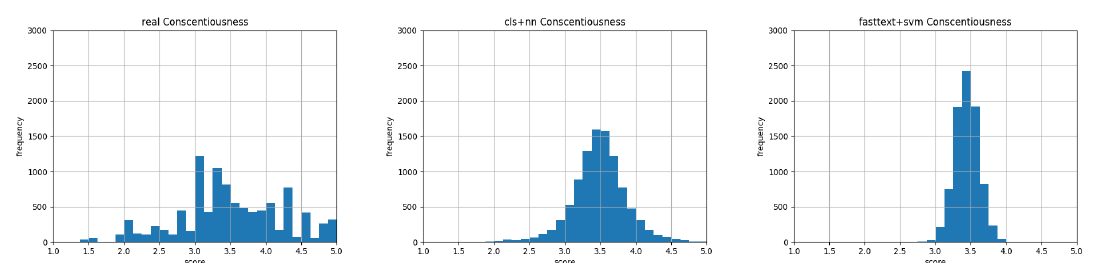
Figure 7. Conscientiousness: Histograms representing data distribution of gold standard on the left, our model result in the middle, and previous state of the art by Carducci et al. [8] on the right.